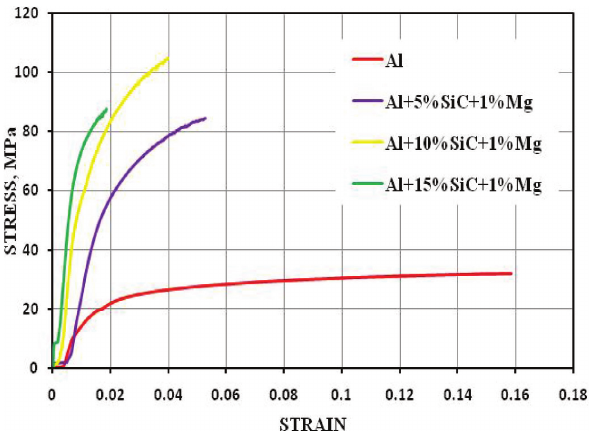
Fig. 7: % elongation of various compositions of SiC and Mg in Al